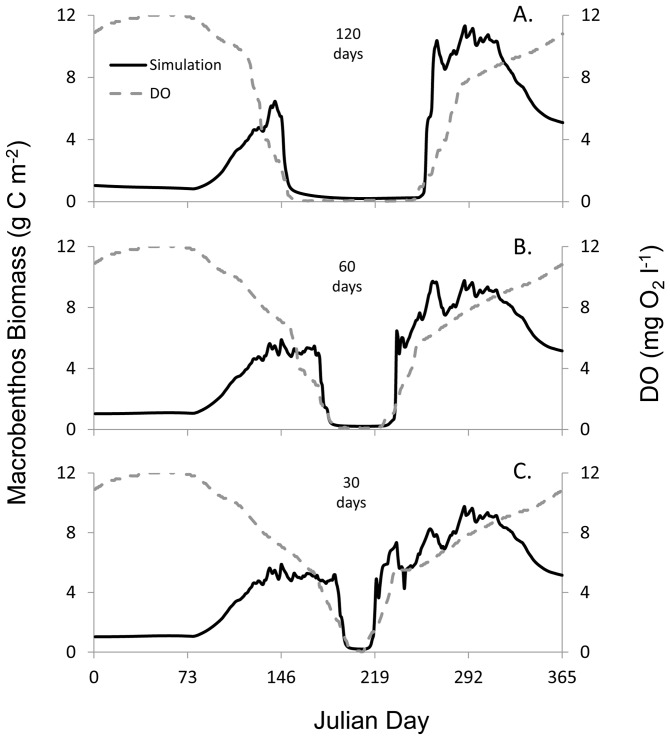
Simulations of hypoxic duration and macrobenthic response.Simulated macrobenthos biomass (B) under hypoxic durations of (A) 120, (B) 60, and (C) 30 days; S1, S2, and S3, respectively. Left y-axis: the gray solid line represents modeled macrobenthos biomass and the black dots denote observed macrobenthos biomass from site LE3.4 of the Chesapeake Bay Benthic Monitoring Program in 1992. Right y-axis: the grey dashed line indicates the dissolved oxygen concentration. B was influenced by the duration of hypoxia.